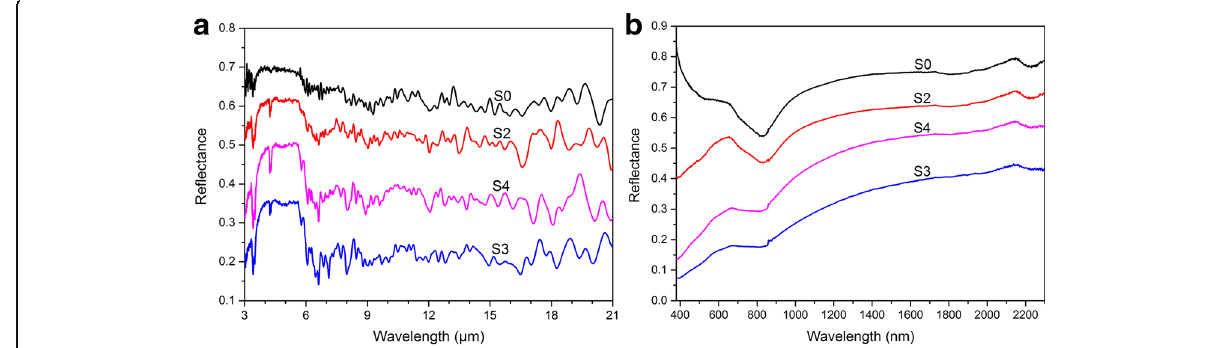
Fig. 4 Total reflectance spectra of the Al/MnO 2 composite pigments in a IR region 3 – 21 μ m and b VIS-NIR region 380 – 2300 nm